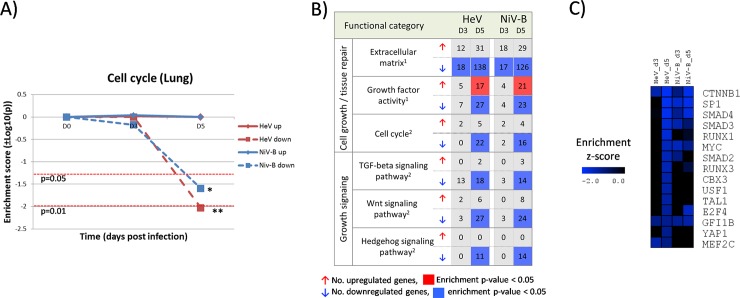
Decreased expression of genes related with cell cycle and growth signaling in the lung tissue during infection with HeV and NiV-B.A) Evolution of gene enrichment score (Fisher’s exact test p-value) of the Cell Cycle KEGG Pathway throughout the infection. B) Functional gene classification of differentially expressed genes in the lung tissue. Regulated genes were subjected to functional classification and selected 1Gene Ontology categories and 2KEGG Pathways that are related to the immune responses and cell growth signaling are shown. For each functional category, the number of up- and down-regulated genes and the level of significance of the enrichment (Fisher’s exact test p-value) are indicated. C) Functional enrichment of down-regulated genes that belong to protein-protein interaction (PPI) hubs of transcription factors.